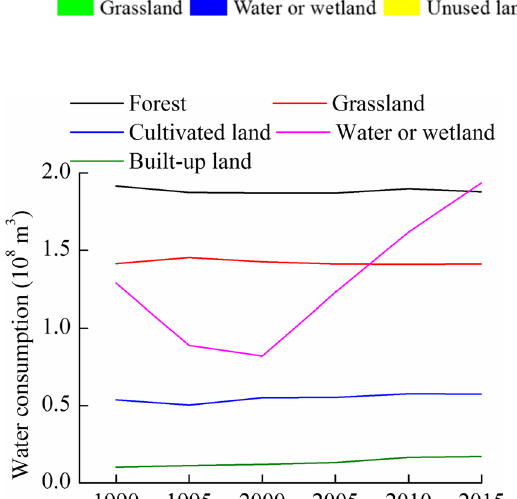
Fig. 3 The water consumption composition in the Ejina Oases from 1990 to